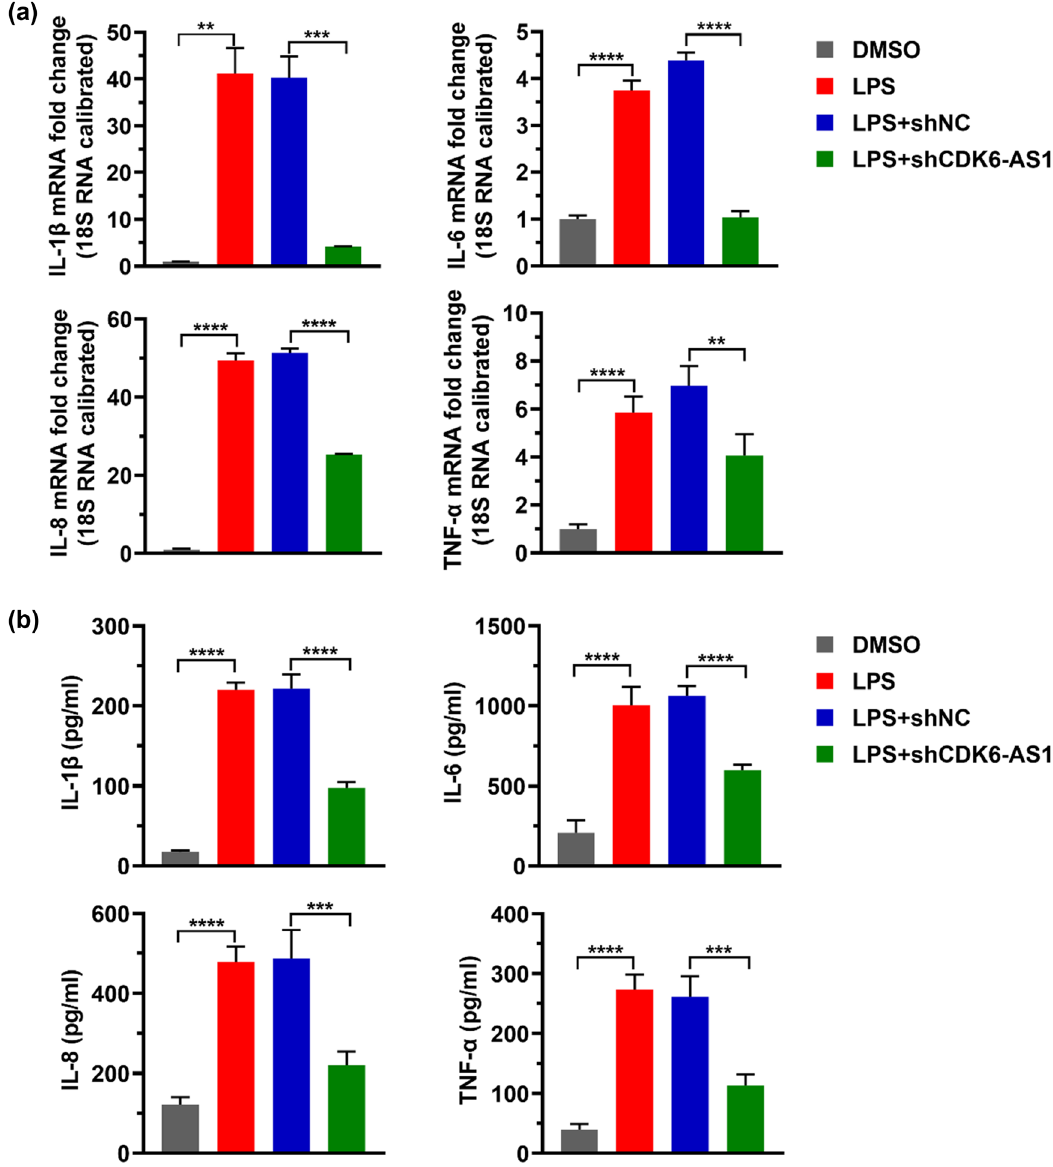
Figure 4: E ff ects of LPS and CDK6 - AS1 on in fl ammatory cytokine: ( a ) the mRNA levels of IL - 1 β , IL - 6, IL - 8, and TNF - α detected by qPCR and ( b ) the secretion levels of IL - 1 β , IL - 6, IL - 8, and TNF - α detected by ELISA assay. ** P < 0.01, *** P < 0.001, **** P <